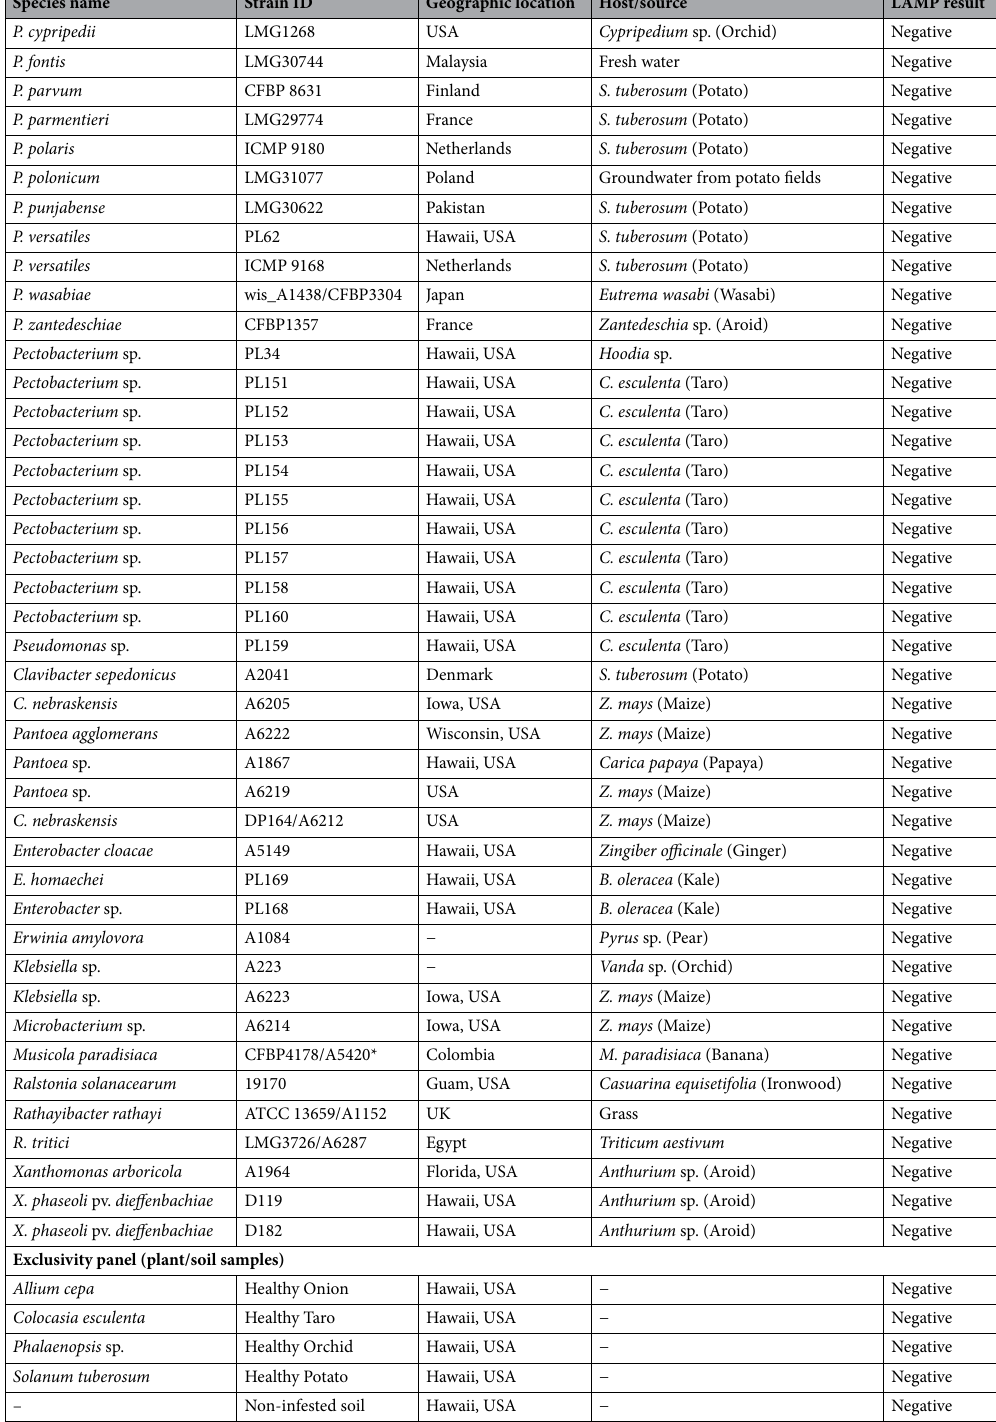
Table 3. Details of bacterial strains, healthy plant hosts and environmental sources, included in inclusive and exclusive panels, used for the validation of Dickeya fangzhongdai specific loop-mediated isothermal amplification (LAMP) assay. Negative (−) signs indicate data not available. T indicates type strain. *Previously known as Dickeya paradisiaca ; Hugouvieux-Cotte-Pattat et al. 41 proposed the species belongs to a newly proposed genus,